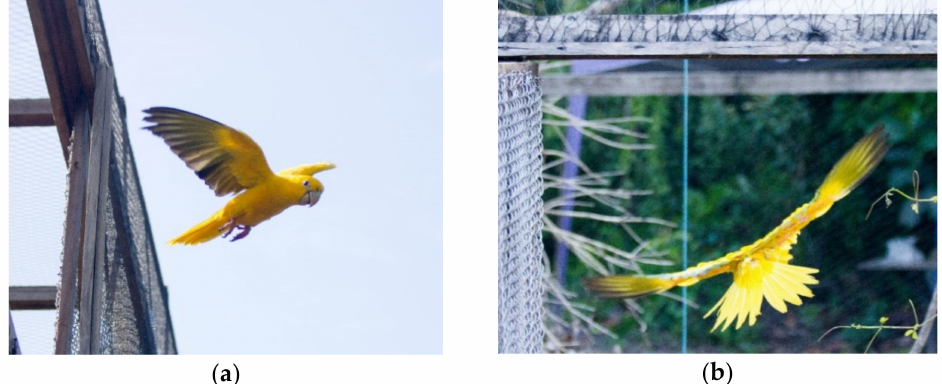
Figure 2. ( a ) A single male being prereleased separately from the group. ( b ) The single male returning to the aviary at the end of the